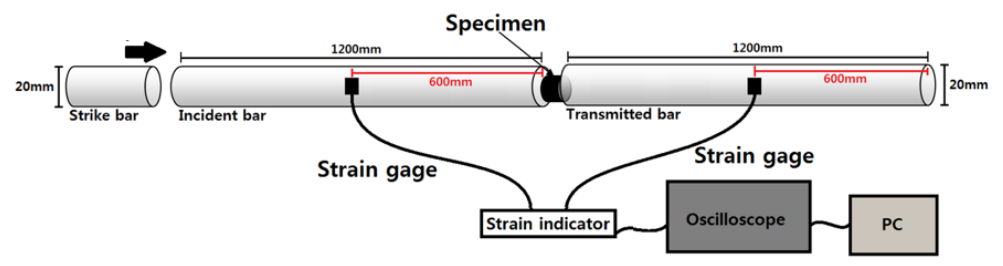
Figure 20. SHPB equipment.